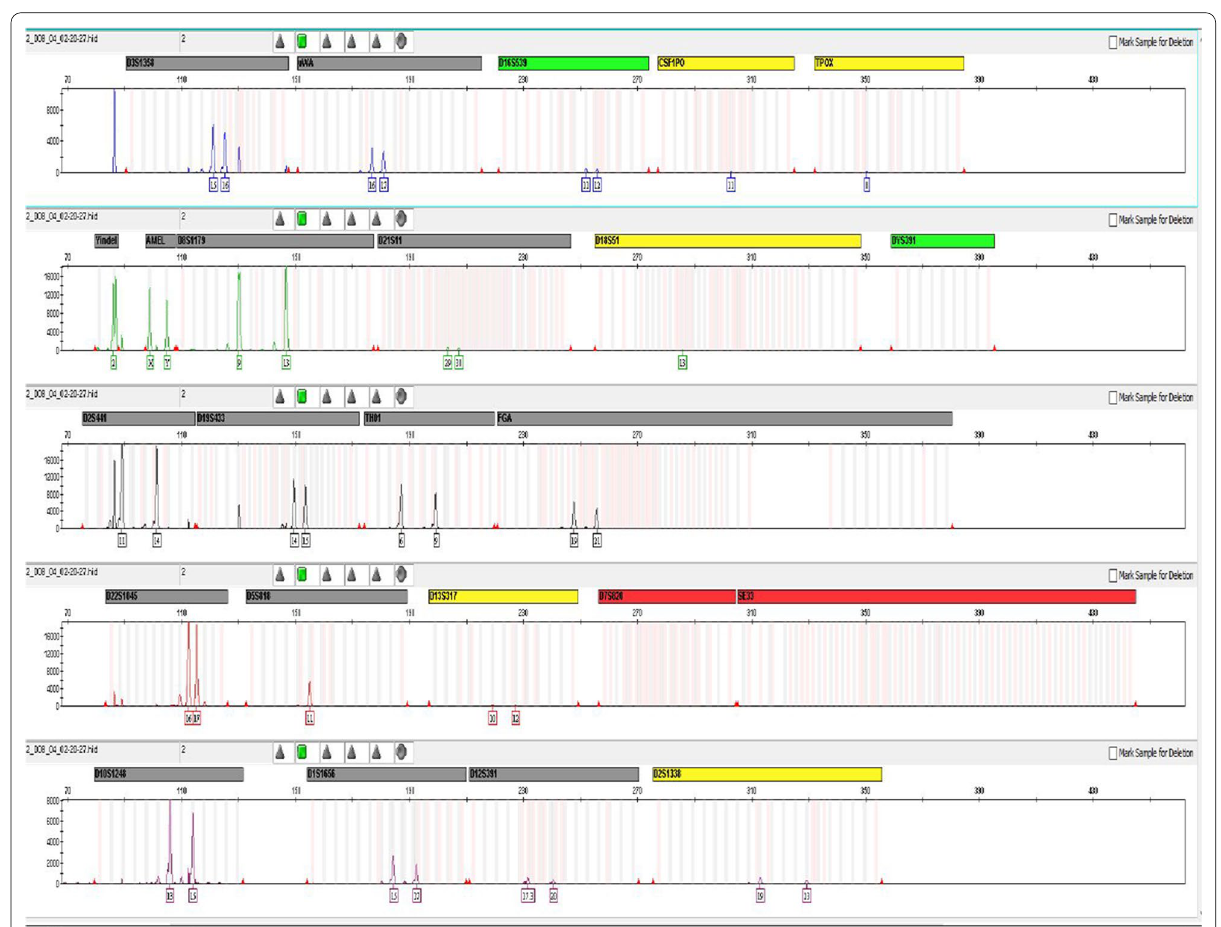
Fig. 6 DNA profile of blood stain in washed nylon fabric at 40 °C extracted by organic DNA extraction method